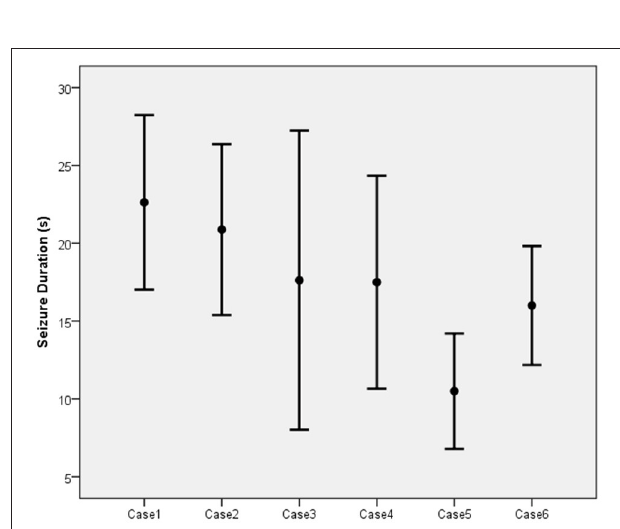
FIGURE 4 | The mean and standard deviation of seizure